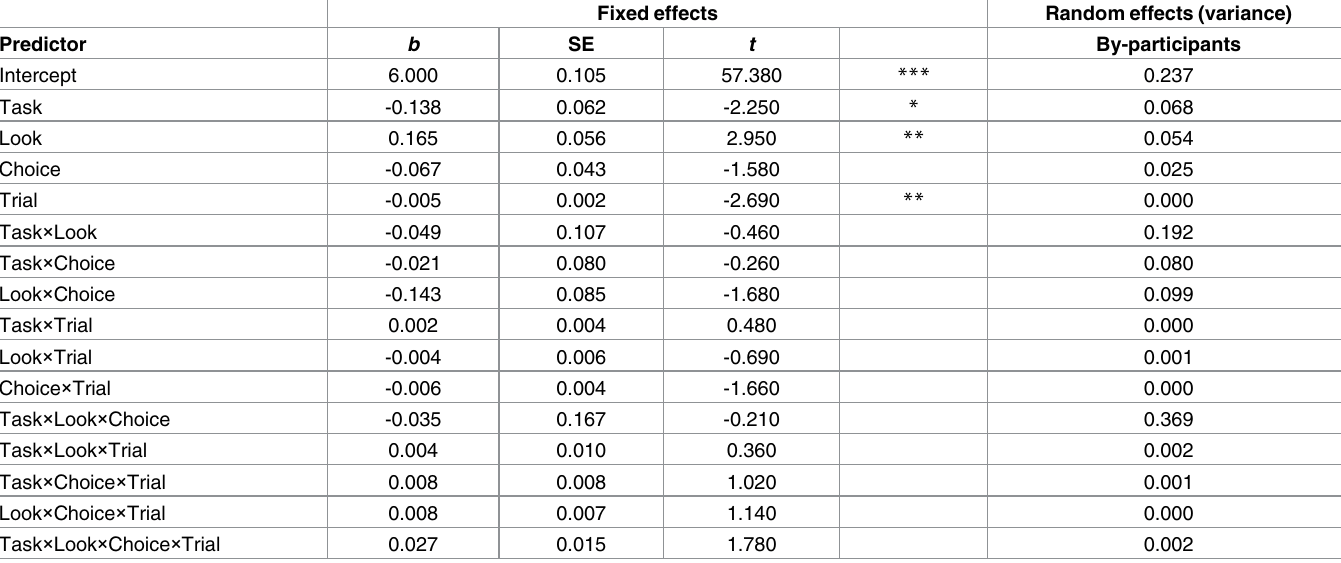
Table 3. Generalized linear mixed models fitting the first dwell time in the snack block in Experiment